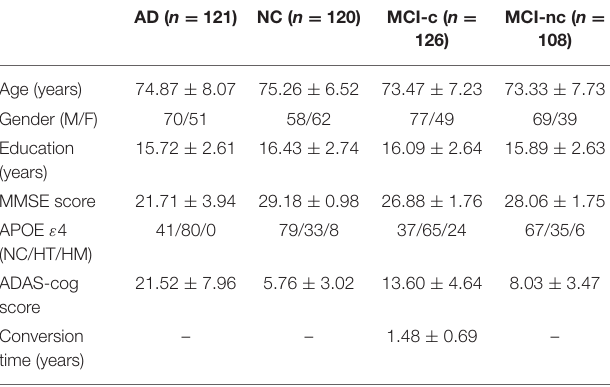
TABLE 1 | The characteristics of participants with AD, NC, MCI-c, and